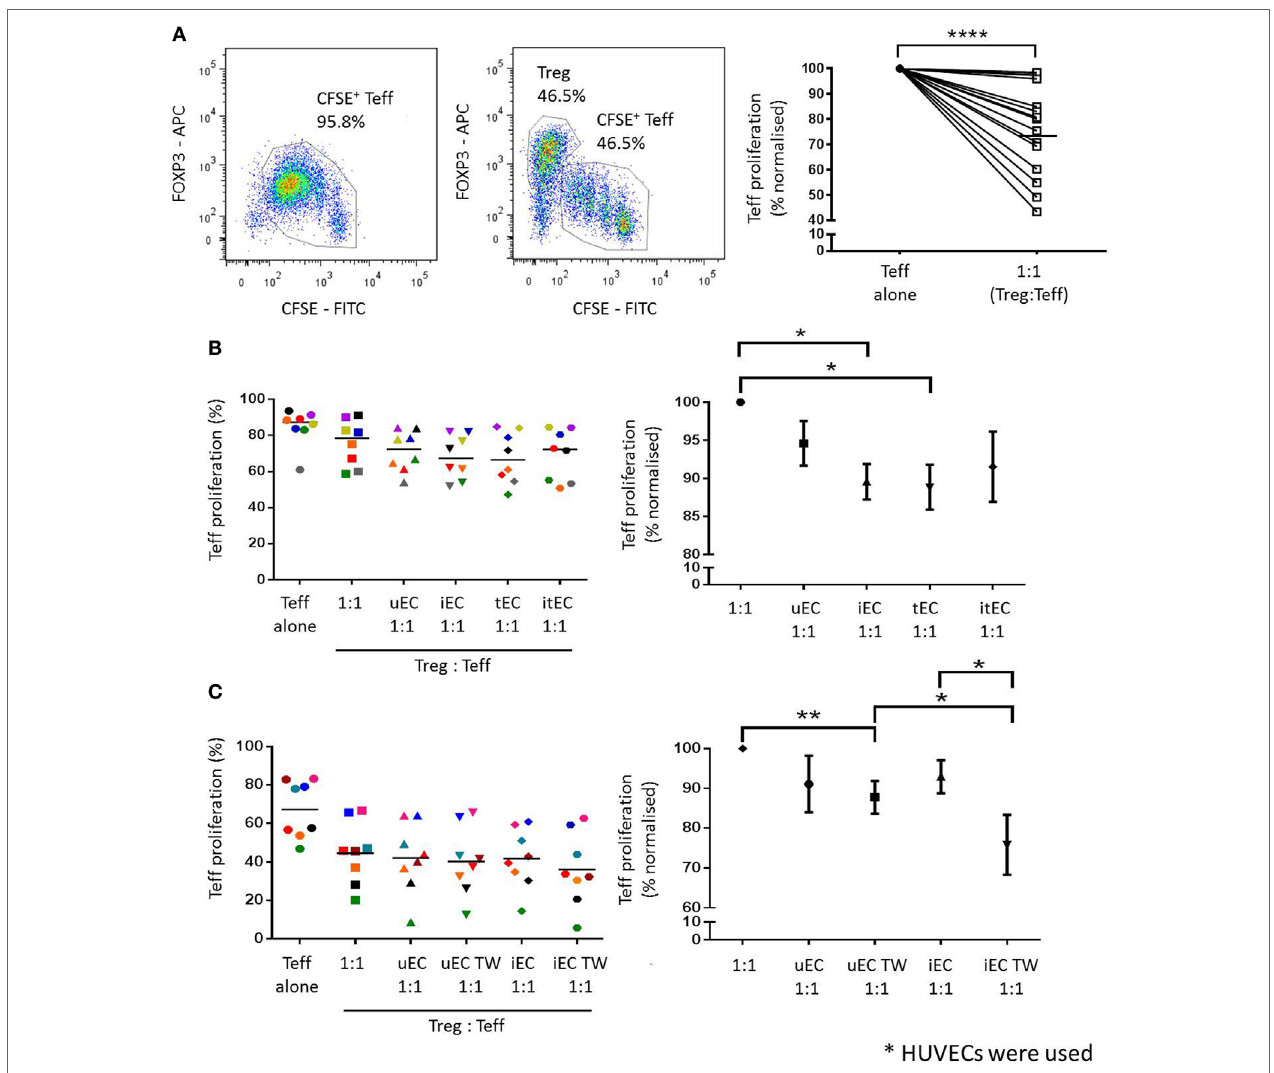
FigUre 3 | Enhancement of Treg suppressor function after coculture with activated human umbilical vein ECs (HUVECs). (a) Treg suppression assays were set up where CFSE-labeled Teffs were either stimulated with 5 µg/mL plate-bound aCD3 antibody (in the presence of gamma-irradiated autologous PBMCs) or with CD4 + CD25 hi CD127 low Tregs at a 1:1 ratio. Teff proliferation was analyzed by CFSE dilution and the suppressive capacity of Tregs was measured by comparing the reduction of Teff proliferation in the presence of Tregs. Tregs from 16 different donors were found to suppress Teff proliferation in